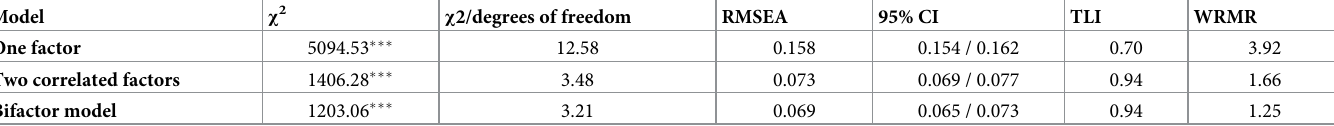
Table 2. Fit indices for the competing models for the empathic experience scale.